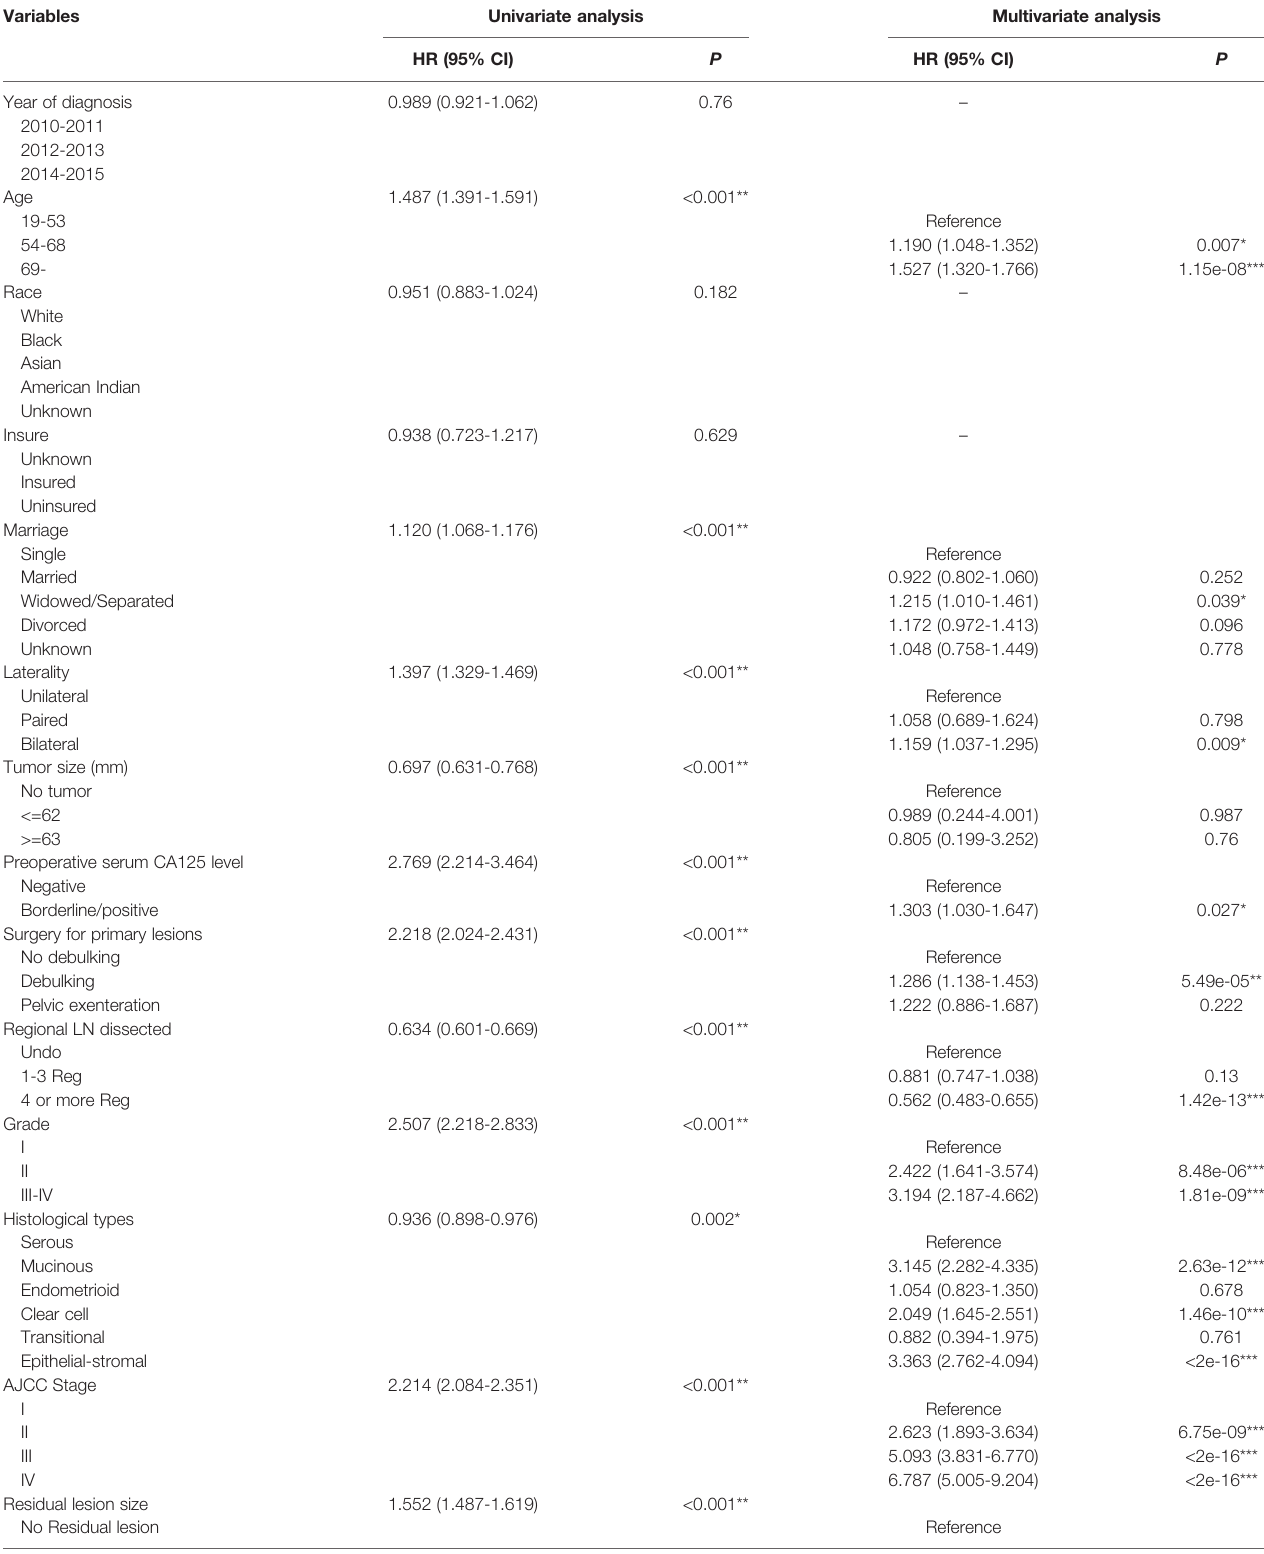
TABLE 2 | Univariate and multivariate Cox regression